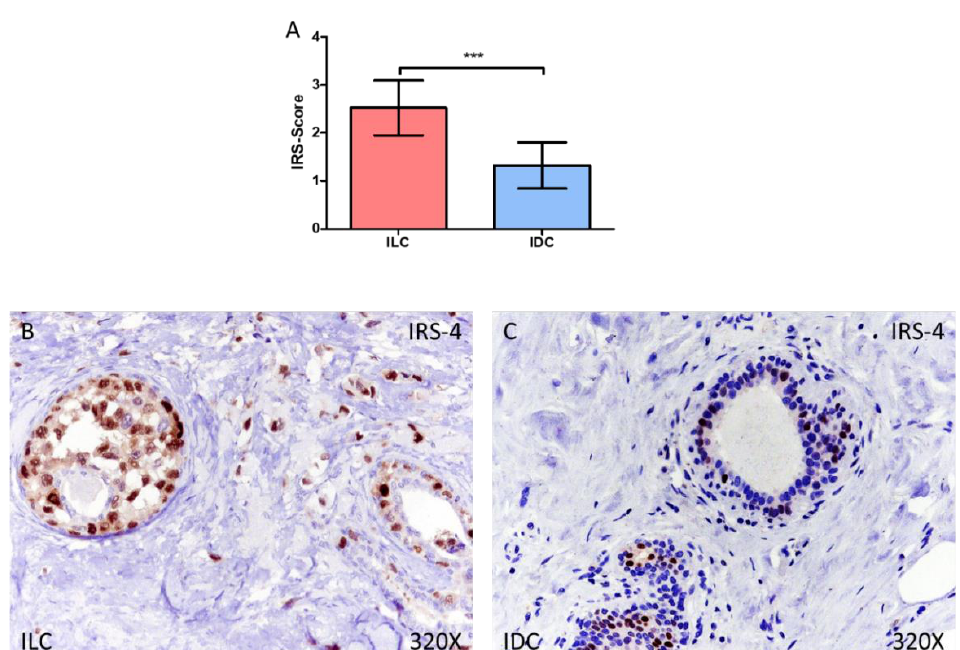
Figure 1. ( A ). IRS-Score for IRS-4 in patients diagnosed with invasive lobular carcinoma (ILC) and infiltrative ductal carcinoma (IDC). ( B , C ). Histological images of IRS-4 expression using immunohistochemical techniques in the breast tissue of patients diagnosed with ILC ( B ) and IDC ( C ). *** p < 0.001.